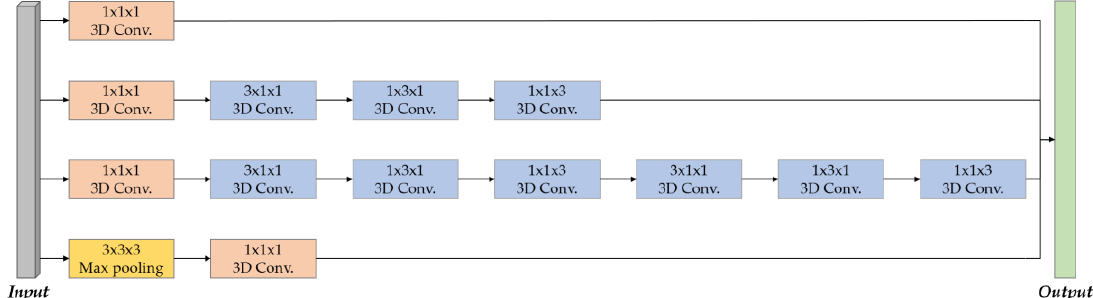
Figure 11. The architecture of a basic block for 3D-CNN.